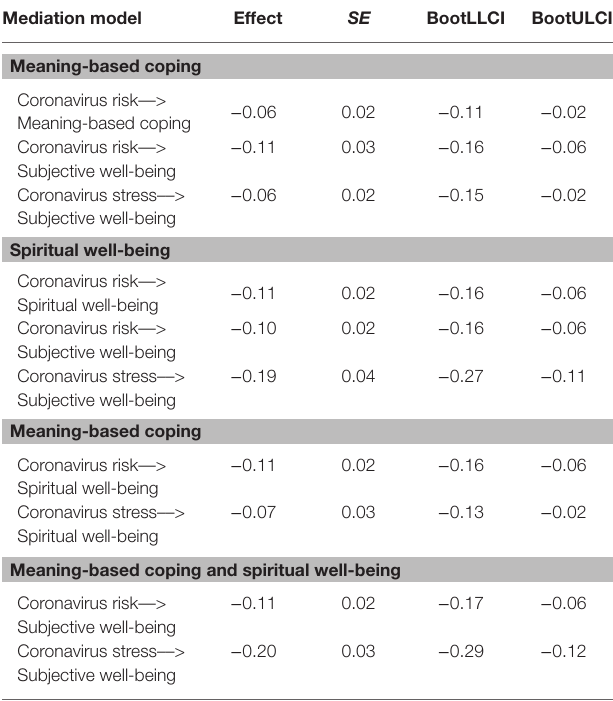
TABLE 3 | Standardized indirect effects. Mediation